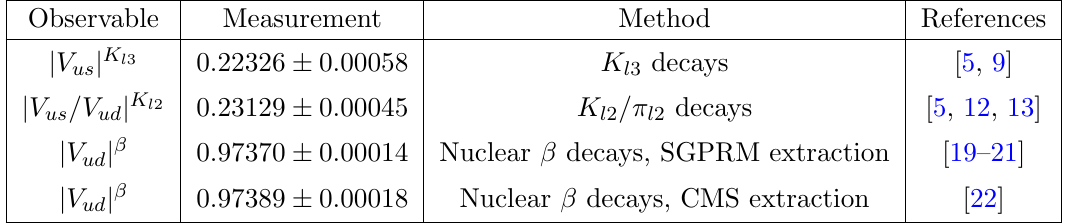
Table 2 . Observables and data used in the (cid:12)ts. In case of the new physics scenario these are interpreted as e(cid:11)ective values, see eqs. (4.1){(4.3). V us and V us =V ud have been extracted from kaon decays [5, 9, 12, 13] using the N f = 2 + 1 + 1 lattice results [8, 43]. The obtained value for V ud depends on the details of the treatment of nuclear (cid:12) decays. There are extractions available from Seng, Gorchtein, Patel, Ramsey-Musolf (SGPRM) [19{21] and Czarnecki, Marciano, Sirlin (CMS) [22] using di(cid:11)erent estimates for the radiative corrections. of order O ( (cid:21) 6